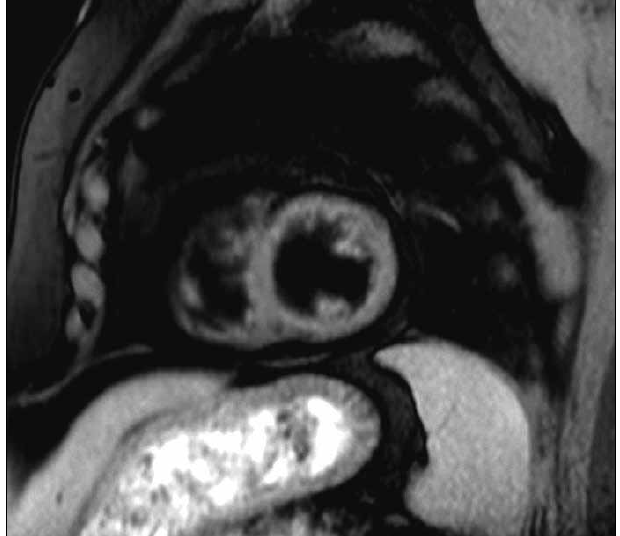
Fig. 2. Short axis dark blood T1 fat sat SPIR TSE TR=612,